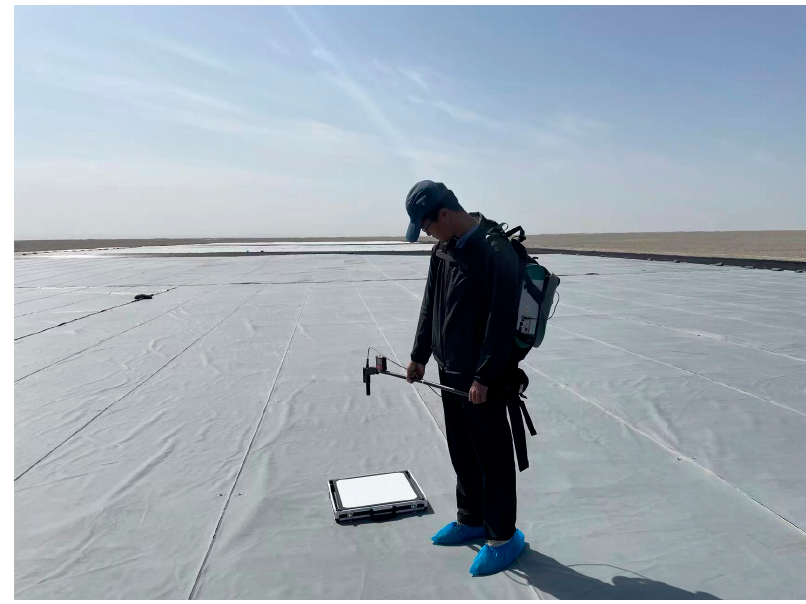
Figure 4. Site test photo.